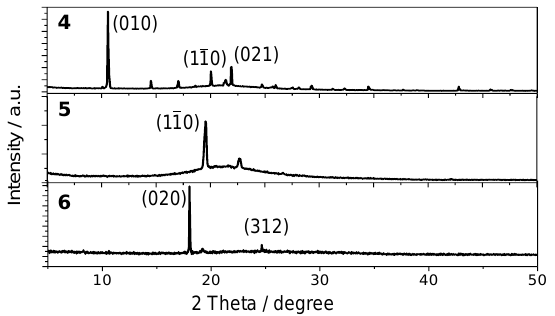
Figure 6. PXRD data of microcrystals of 4 – 6 .